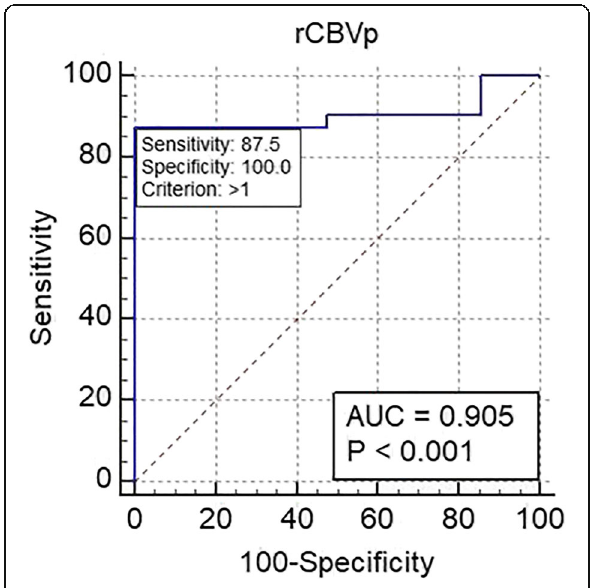
Fig. 5 ROC Curve rCBVp